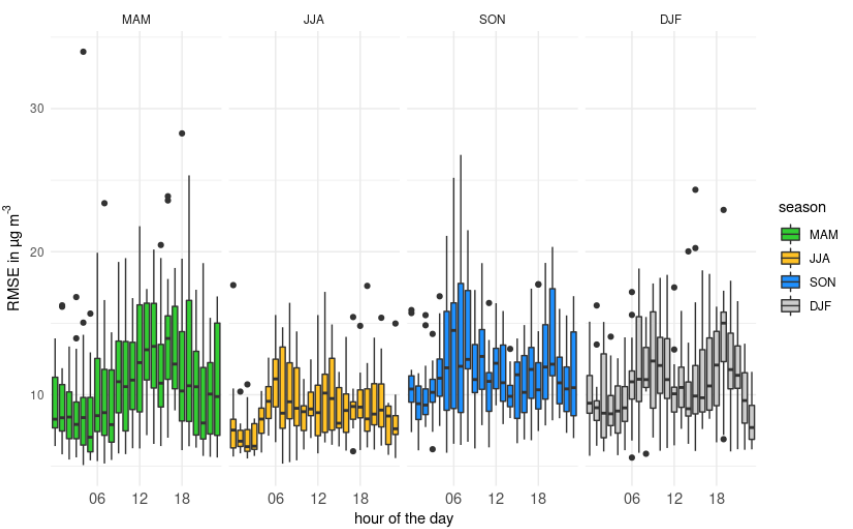
Figure 5. Root Mean Square Error (RMSE) boxplots of the leave-one-out cross-validation (loo-cv) of run 7 with dataset (1) depending on the hour of the day and the